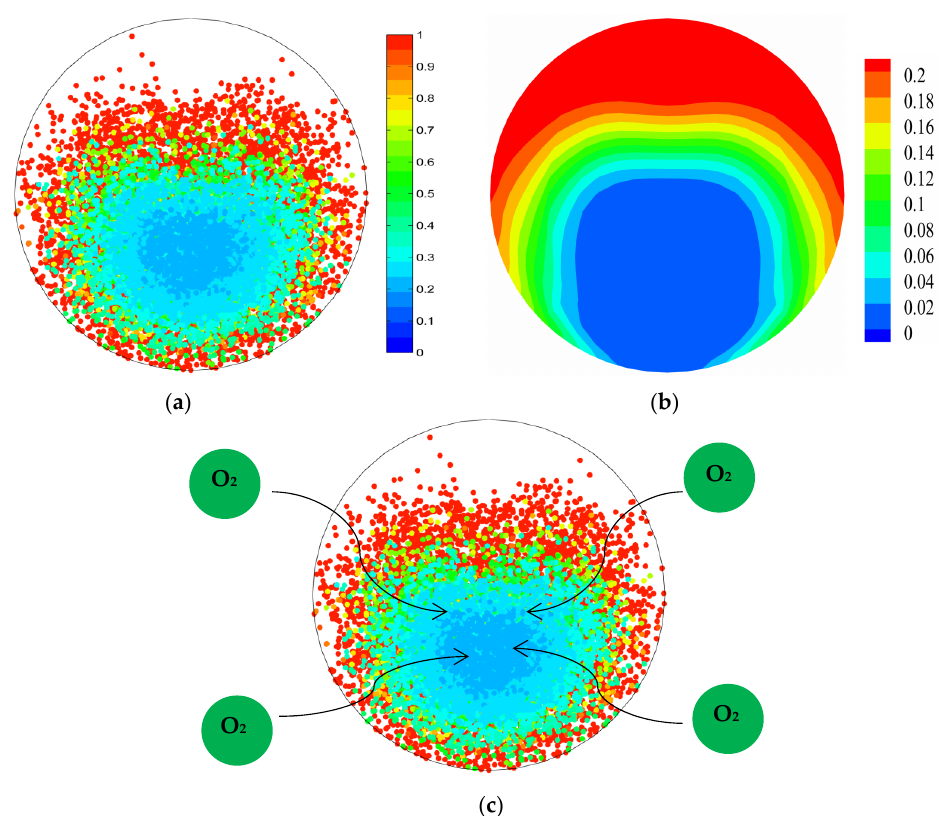
Figure 7. Raceway outlet: ( a ) coal burnout distribution; ( b ) oxygen distribution; ( c ) concept of targeted oxygen enrichment.